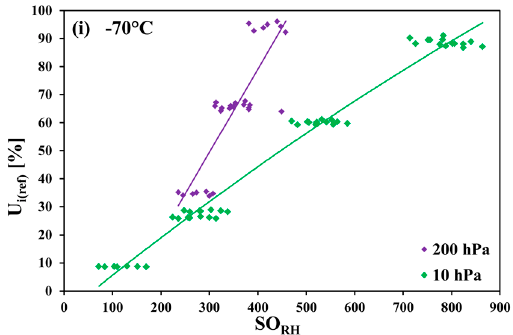
Figure 1. Pressure dependencies of the SHT75 sensors in CO 2 (regression lines fitted to measurement points collected from all tested sensors at different temperature/pressure combinations) at temperatures from − 70 °C to 10 °C; SO RH are the integer rough values (SO means ‘sensor output’, i.e., the humidity readout) of the SHT75 sensors.